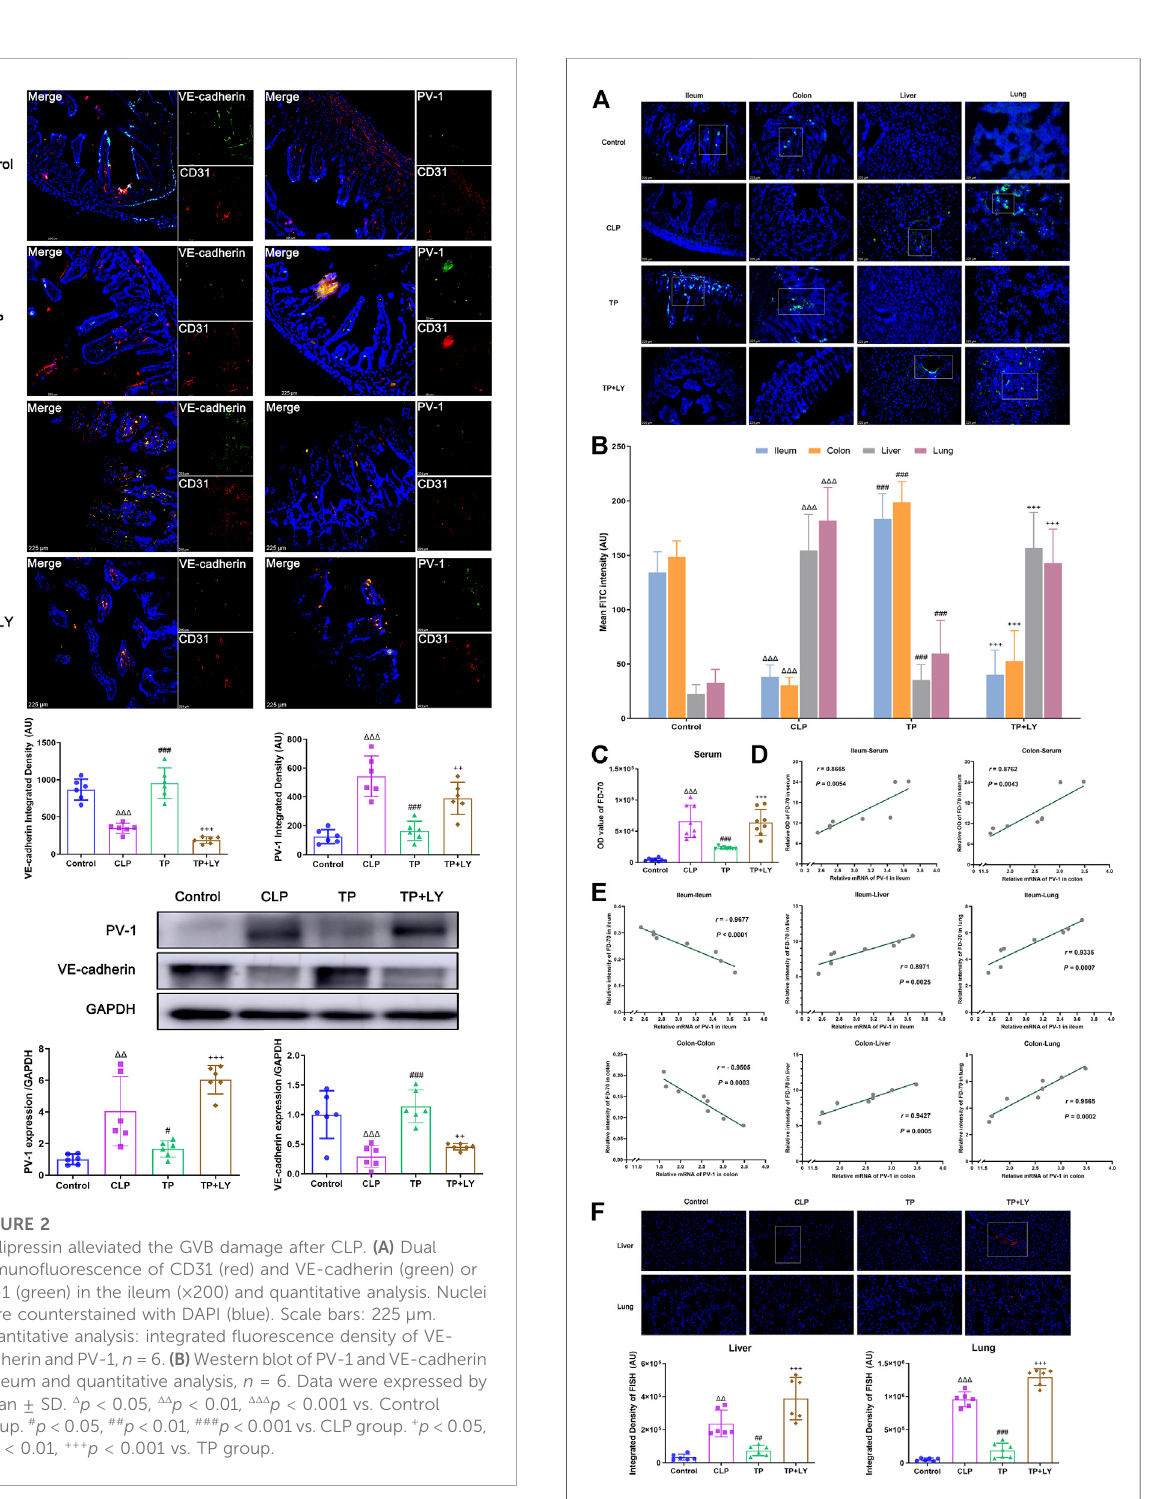
FIGURE 3 Terlipressin attenuated the translocation of intestinal macromolecules and bacteria after CLP. (A) Distributions of FD70 (green) in ileum, colon, liver and lung (×200). Nuclei were counterstained with DAPI (blue). Scale bars: 225 μ m. (B) Quantitative analysis: fl uorescence density of FITC, n = 8. (C) The OD value of FD-70 in serum, n = 8. (D) The correlation analyses ( Continued